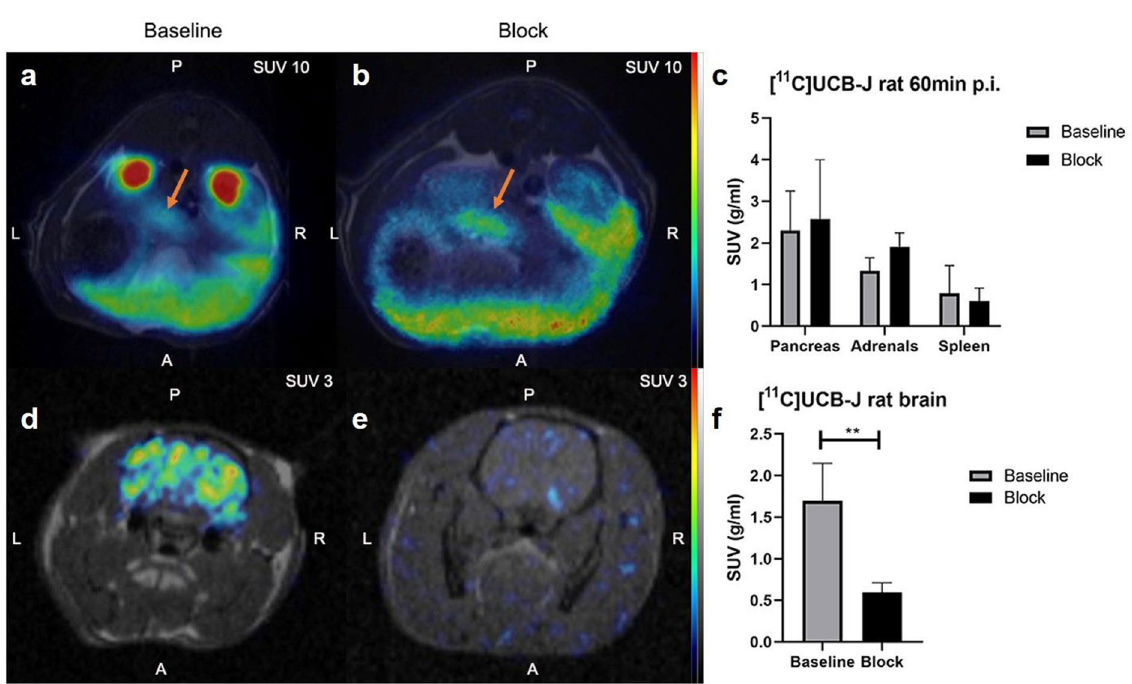
Figure 3. In vivo PET-MRI imaging in rat. Representative abdominal ( a ) 60 min p.i. and brain ( d ) PET-MRI images at baseline. Pretreatment did not abolish binding in pancreas (orange single arrow) ( b ), while blocking was efficient in the brain ( e ), as demonstrated by representative images. Quantification of tissue uptake verified poor or negligible blockade of abdominal binding with 30 mg/kg LEV ( c ), while binding in the brain was reproducibly inhibited ( f